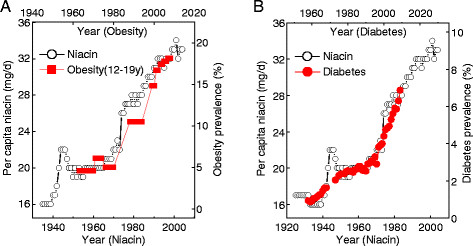
Trends in U.S. per capita niacin consumption and the prevalence of obesity and diabetes. The prevalence of obesity (A) and diabetes (B) increased in parallel with the increase in U.S. per capita niacin consumption with a lag of 10 years and 26 years, respectively (see Ref. [9,35] for detail). The sharp increase in niacin consumption in 1940s and 1974 is due to the implementation of mandatory grain fortification and the update of fortification standards, respectively. The data on the prevalence of obesity and diabetes are from the U.S. Centers for Disease Control and Prevention (http://www.cdc.gov/nchs/data/hestat/obesity_child_07_08/obesity_child_07_08.htm; and http://www.cdc.gov/diabetes/statistics/slides/long_term_trends.pdf. Accessed March 24, 2012). The data on U.S. per capita consumption of niacin is from Economic Research Service: Nutrient Availability Spreadsheets, (http://www.ers.usda.gov/data/foodconsumption/NutrientAvailIndex.htm. Accessed March 24, 2012).